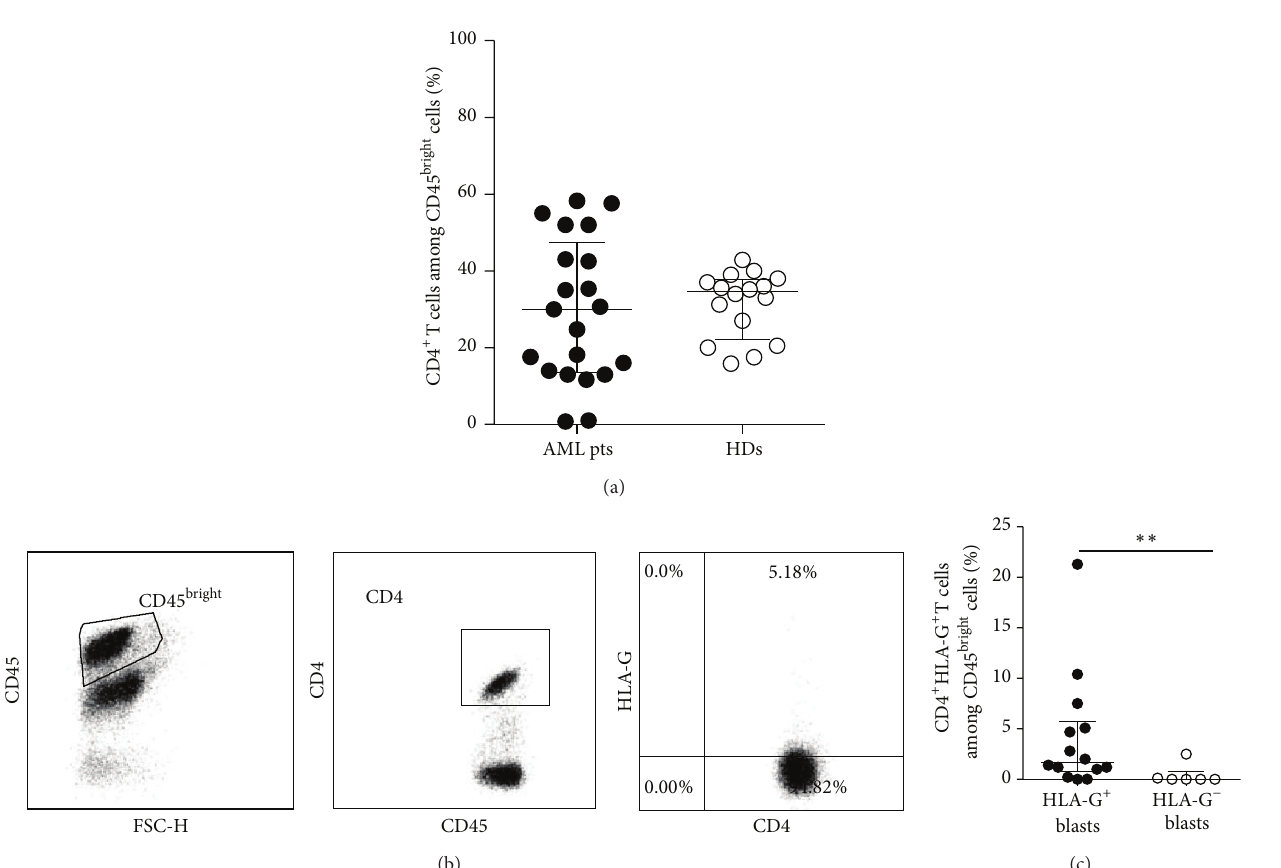
Figure 3: Flow cytometric analysis of CD4 + T cells in the peripheral blood of AML patients. (a) Percentages of CD4 + T cells among the CD 45 bright cells in the peripheral blood of AML patients (AML pts) and healthy donors (HDs) are shown. Each dot represents single AML patient or HD. Lines indicate the median and interquartile range of positive cells detected in all patients and donors analyzed. (b) Representative dot plots of HLA-G + CD4 + T cells are depicted. (c) Percentages of HLA-G + CD4 + T cells in patients with HLA-G + or HLA- G − blasts are shown. Each dot represents single AML patient. Lines indicate the median and interquartile range of HLA-G + CD4 + T cells. ∗∗ 𝑃 < 0.01